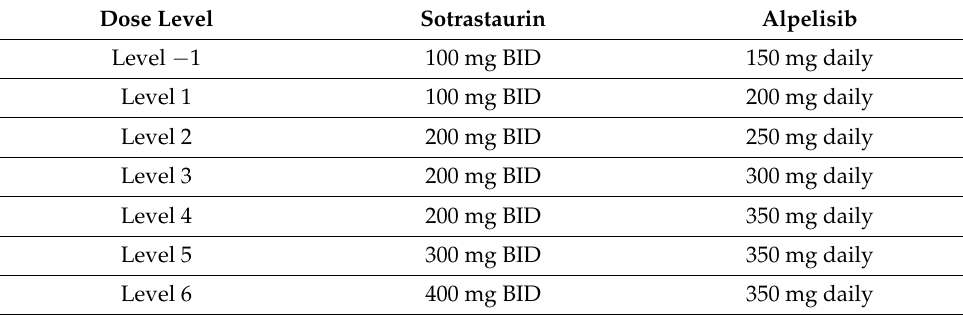
Table A1. Dose levels.